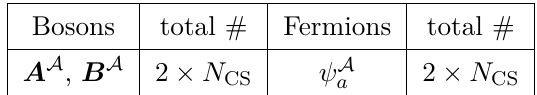
Table 2 . The summary of on-shell component fields in the CS+nCS-A